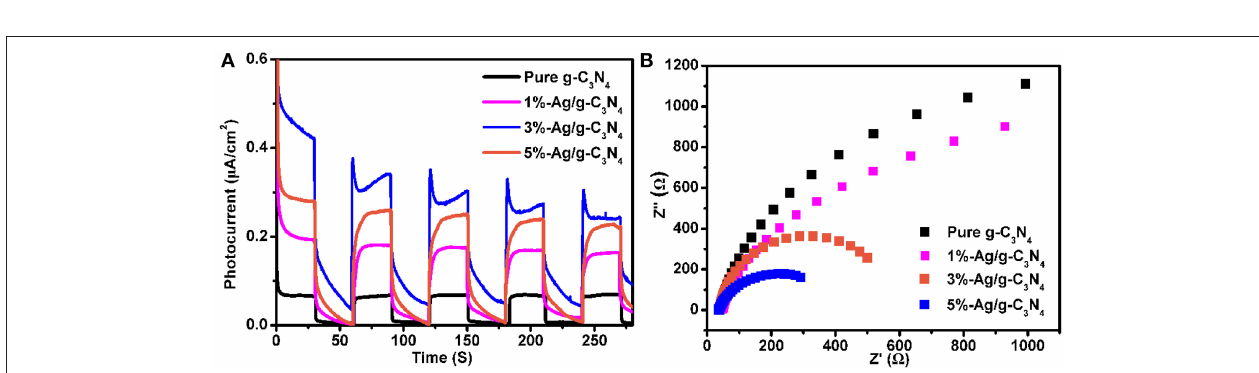
FIGURE 8 | (A) photocurrent response and (B) electrochemical impedance spectroscopy of the pure g-C 3 N 4 , 1%-Ag/g-C 3 N 4 , 3%-Ag/g-C 3 N 4 , and 5%-Ag/g-C 3 N 4 samples.